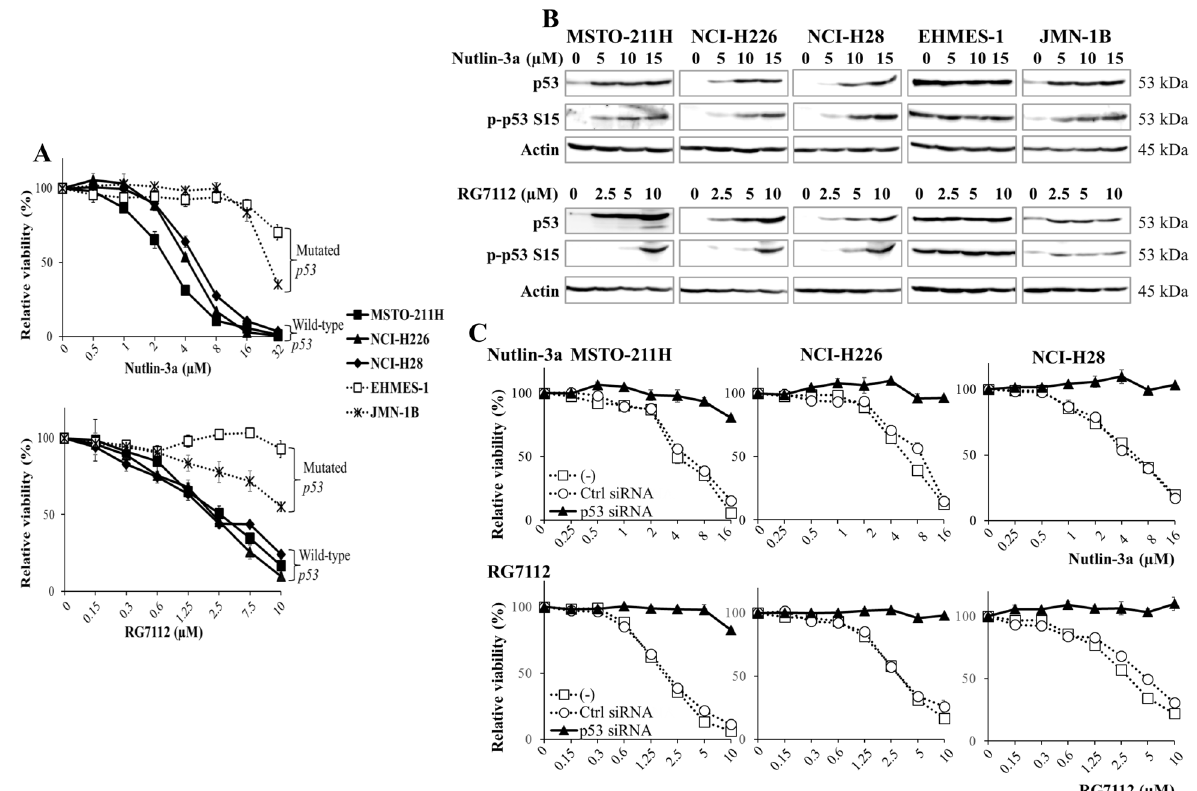
Fig. 2 MDM2 inhibitors increased p 53 expression in wild-type p53 mesothelioma and the growth inhibition was relevant to p 53 genotype. A Cells were treated with various concentrations of nutlin-3a for 4 days or RG7112 for 3 days. The cell viabilities were measured with the WST agent and relative viability was calculated based on untreated cells. Averages and SE bars are shown ( n = 3). B Cells were treated with various concentrations of nutlin-3a or RG7112 as indicated for 2 days. Expression of p53 and phosphorylated p53 at Ser 15, and actin as a control was examined with western blot analysis. C Cells transfected with p53 siRNA or control siRNA were treated with various concentrations of nutlin-3a or RG7112 for 3 days and the cell viabilities were measured with the WST agent. Relative viability was calculated based on untreated cells. Averages and SE bars are shown ( n =